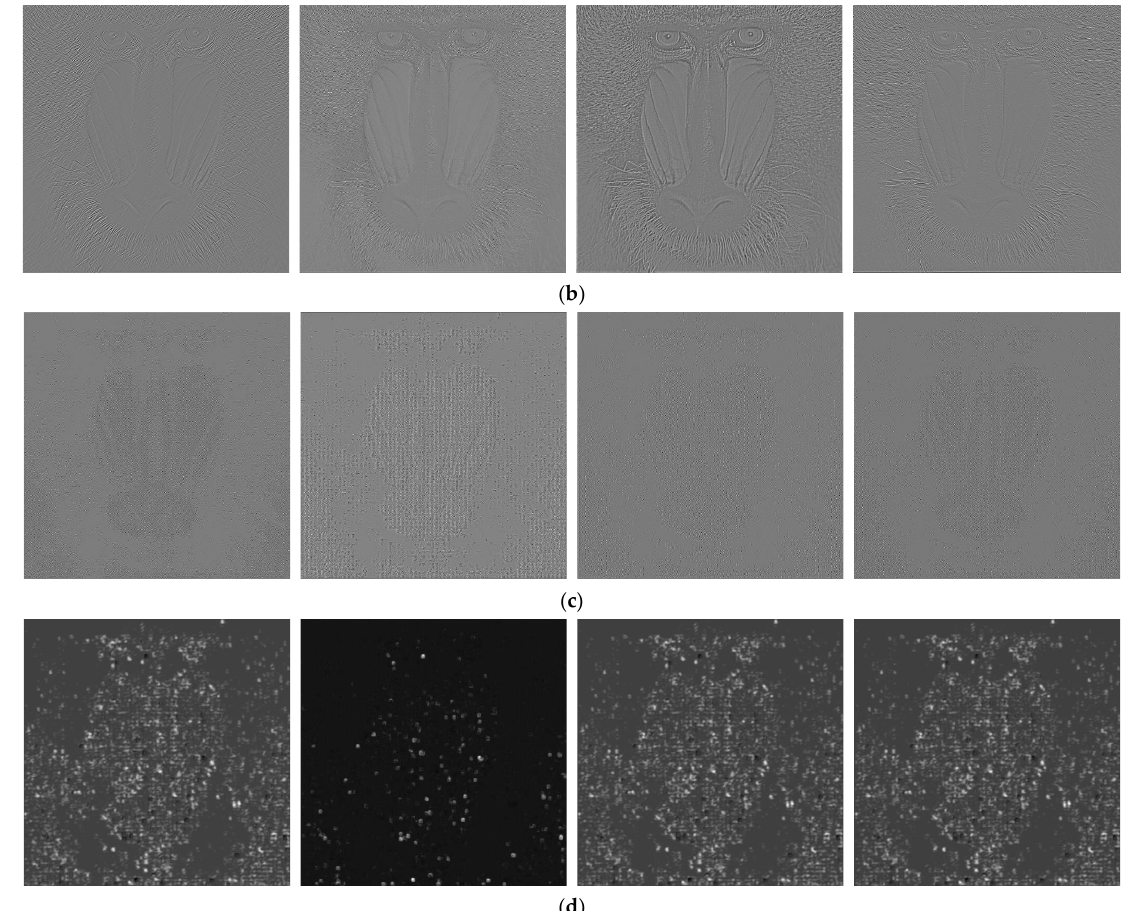
Figure 6. Effect of different layer kernels. ( a ) An image, ( b ) layer 3 kernels effect, ( c ) layer 13 kernels effect, ( d ) layer 28 kernels effect. effect, ( d ) layer 28 kernels